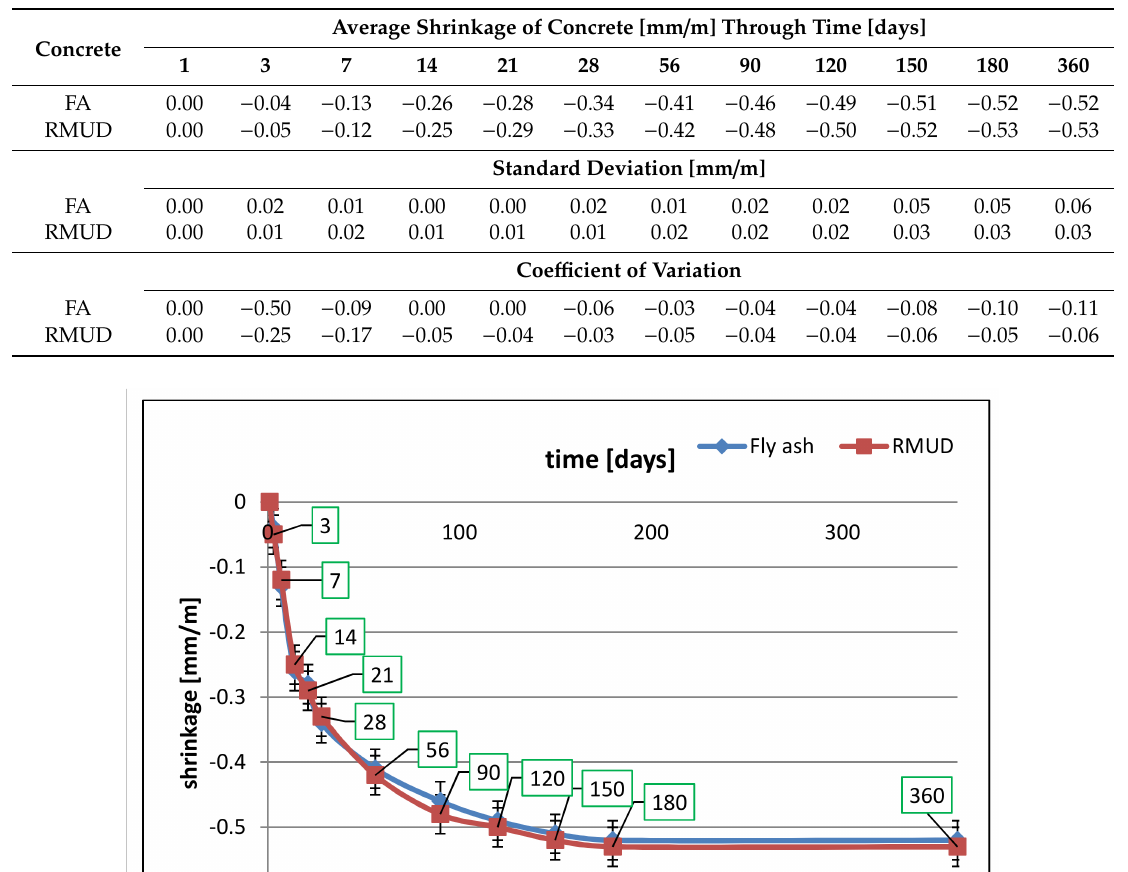
Table 6. Results of shrinkage test.